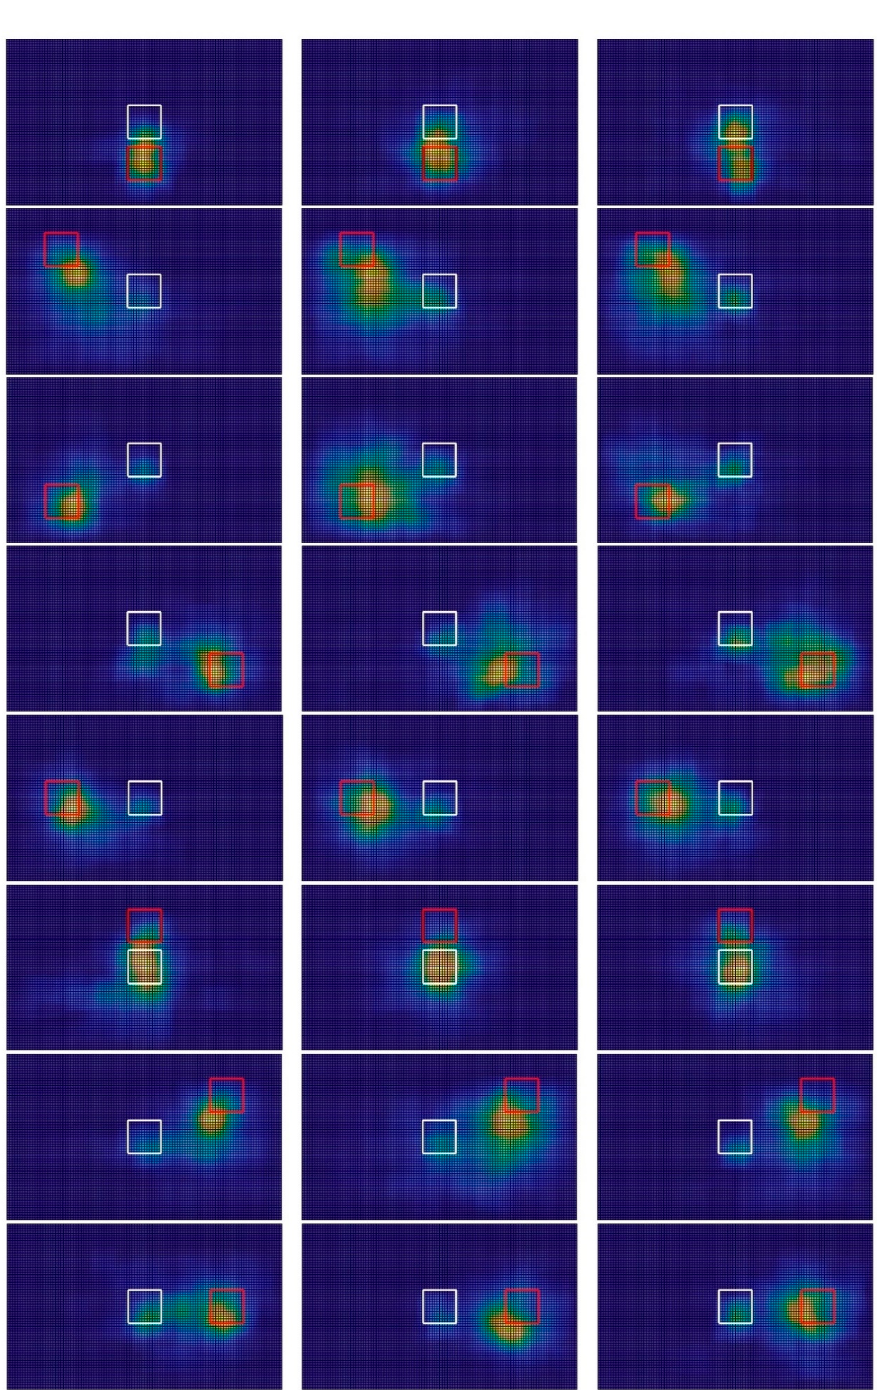
Figure 7. VES-PVAS average foveal gaze-tracking heatmaps of test 3. Each column corresponds to all element trajectories, starting from the center, under the conditions of no delay, 500 ms delay and N (500, 100) ms delay. The white and red boxes represent the starting and ending position of the